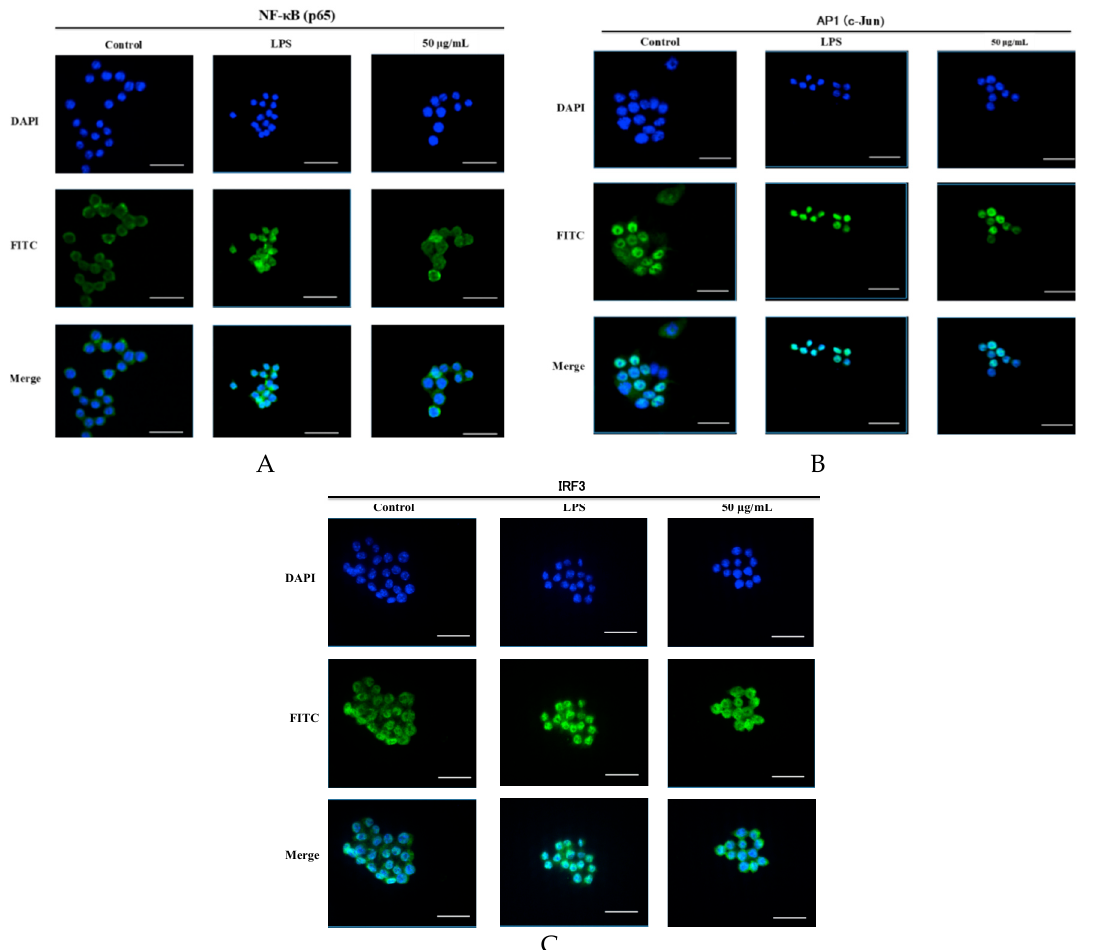
Figure 8. Effect of SCL on the nuclear translocation of NF- κ B, AP-1 and IRF3 in LPS-stimulated RAW264.7 cells. Cells were pre-treated with SCL in different concentrations as indicated for 1 h and then stimulated with LPS for 60 min. The subcellular localization of NF- κ B (p65), AP-1 (c-Jun), and IRF3 was determined using an immunofluorescence assay ( A – C ). The images of these three transcriptional factors were acquired by confocal microscope. The bar in each image represents 33 μ m.